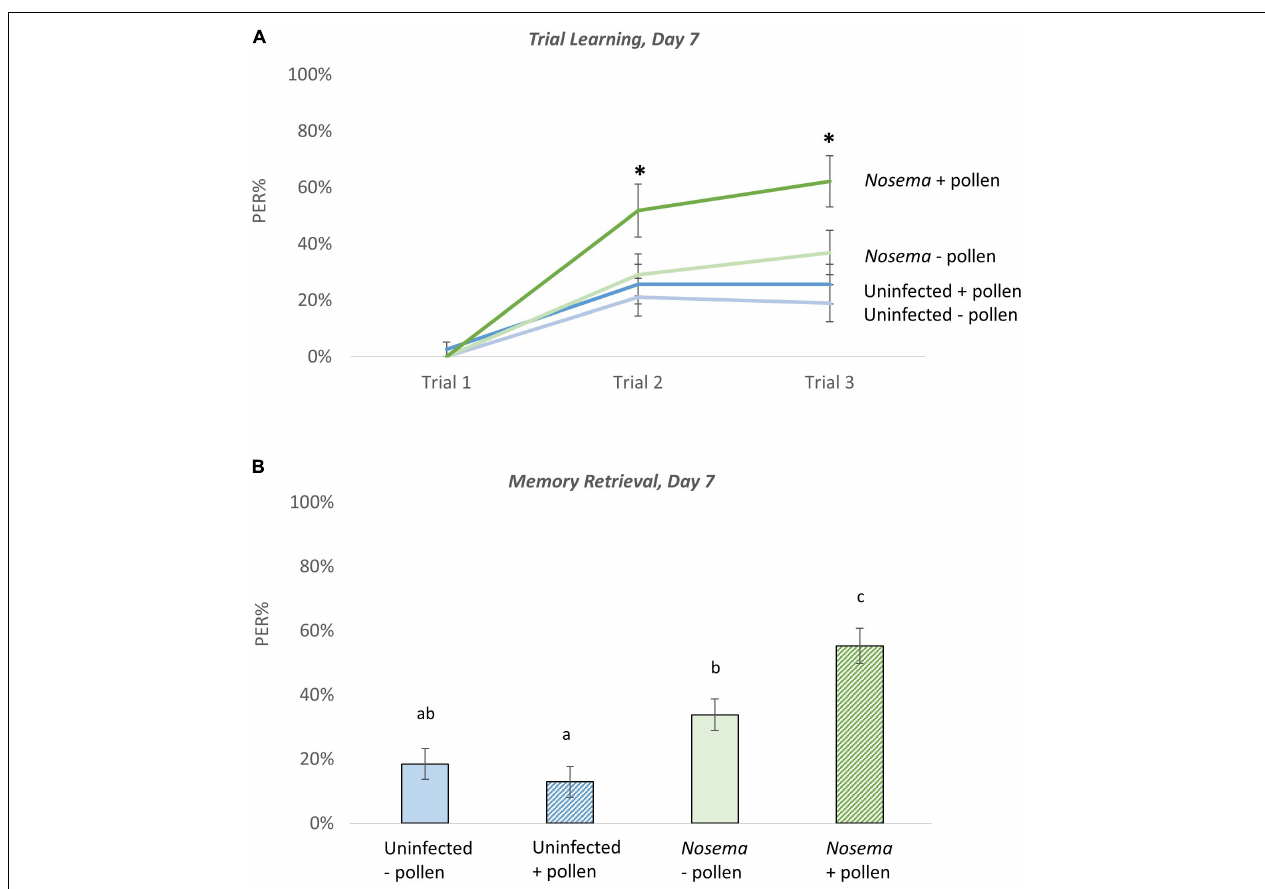
FIGURE 4 | The effects of pollen and Nosema ceranae on odor learning and memory at Day 7. Proboscis extension response (PER) was measured among four groups of bees including: bees pollen ( N = 39, 38) and N. ceranae -infected bees pollen ( N = 30, 38). The PER response of each group was tested as bees were trained to associate an odor with a reward (Trial Learning, A ). Memory retrieval (B) of the conditioned stimulus was measured 10 min after trial learning by presenting the odor alone. Significance( ∗ ) was determined using separate Wilcoxon tests for Trial 2, Trial 3, and Memory Retrieval. Groups connected by the same letter are not significantly